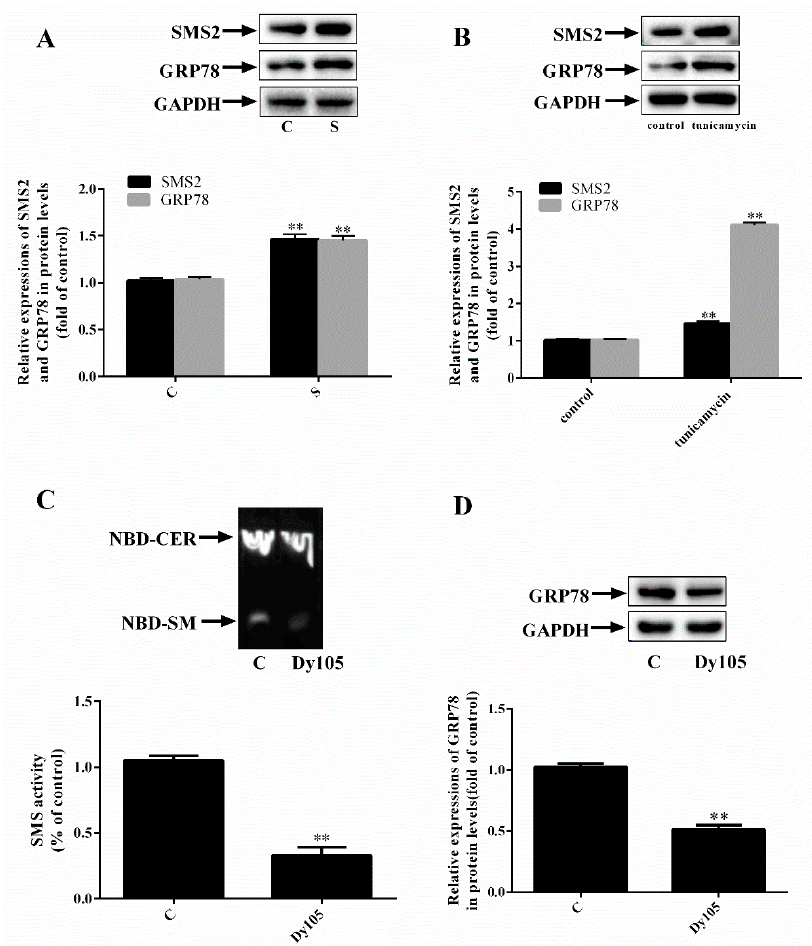
Figure 1. Sphingomyelin synthase 2 (SMS2) overexpression activates endoplasmic reticulum